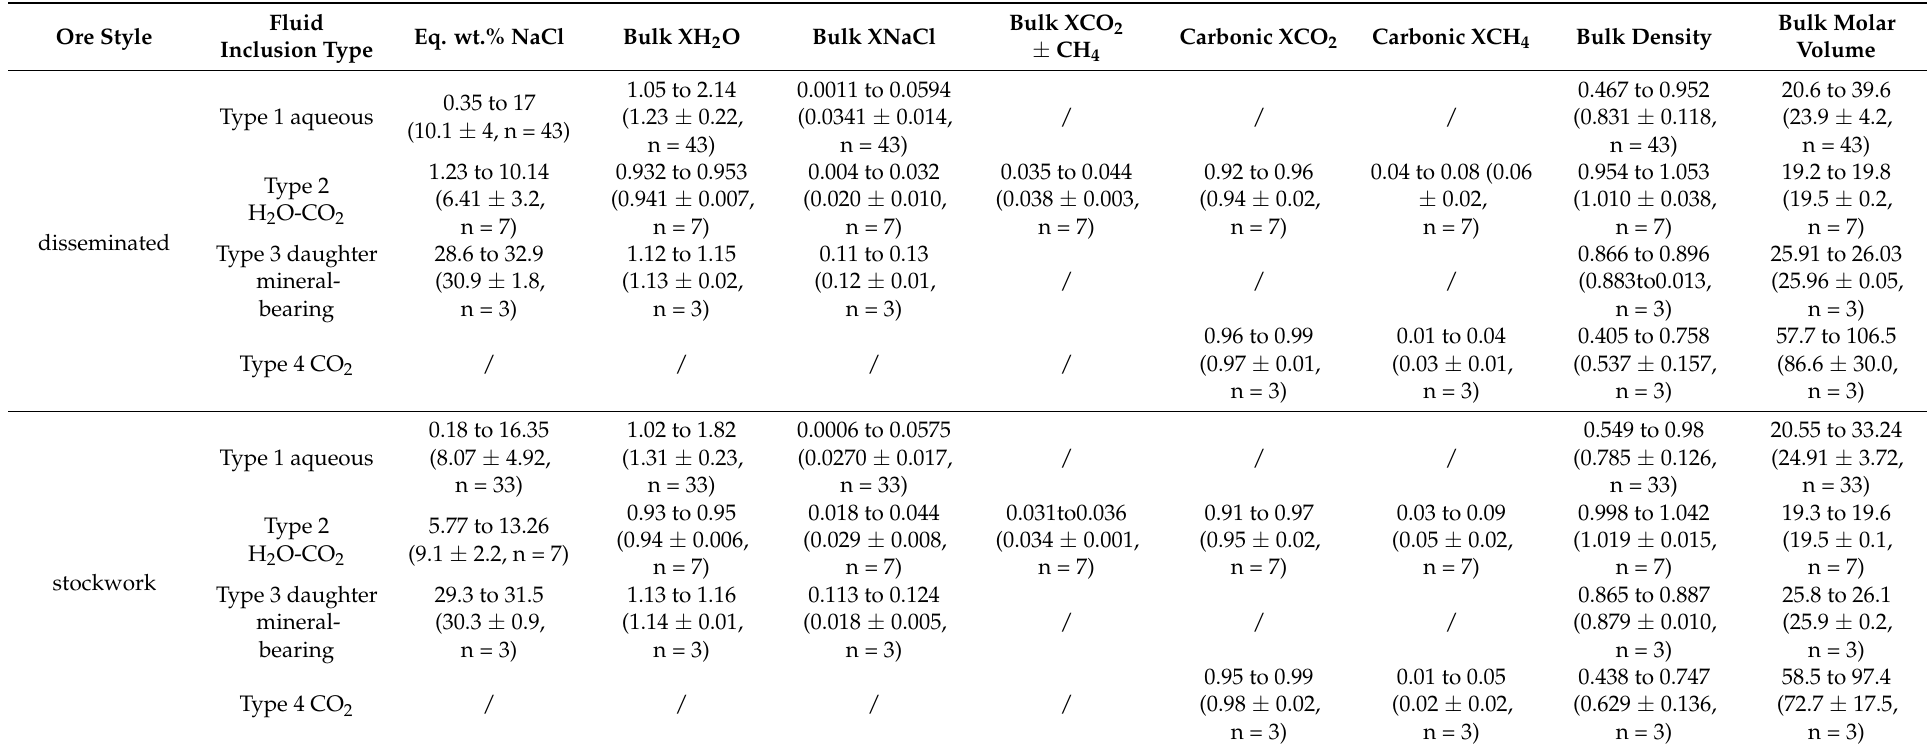
Table 2. Composition of fluid inclusions trapped in quartz at the Xiawolong gold deposit. Note: data are given as mean, 1 σ standard deviation, range, and number of